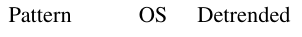
Table 1. Correlation coefficients between WHD NCP and three tele- connection (EA/WR, WP, and EU) indices. A single asterisk ( ∗ ) indicates that the result exceeded the 95% confidence level, and double asterisks ( ∗∗ ) indicate that it exceeded the 99% confidence level. Note: OS means “original sequence”, and “detrended” means that the linear trend was removed. Pattern OS Detrended EA/WR 0.36 ∗ 0.43 ∗∗ WP − 0.06 0.41 ∗ EU 0.34 ∗ −